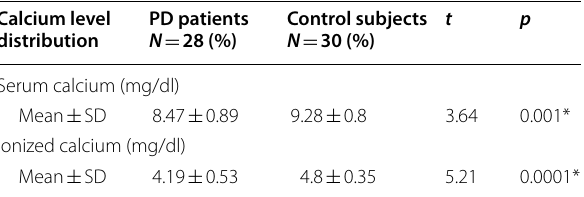
Table 3 Calcium level distribution between patients and control subjects